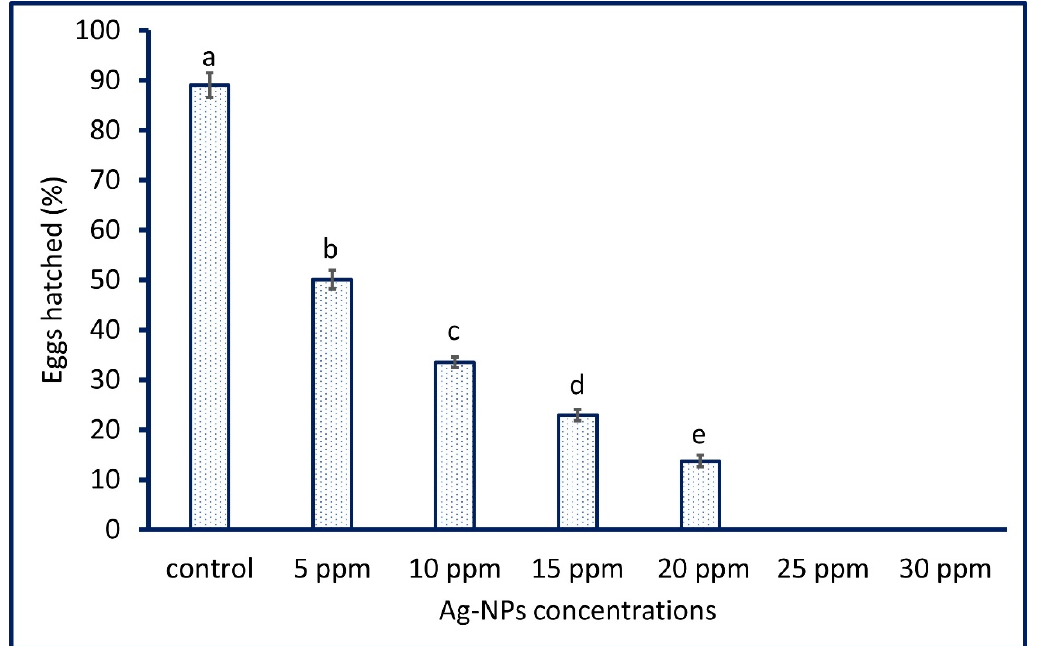
Figure 5. The eggs hatched percentages (%) of A. aegypti after treatment by mycosynthesized Ag-NPs at various concentrations. Data are represented by the mean ± SD ( n = 5). Different letters between the column are significantly different ( p < 0.05).